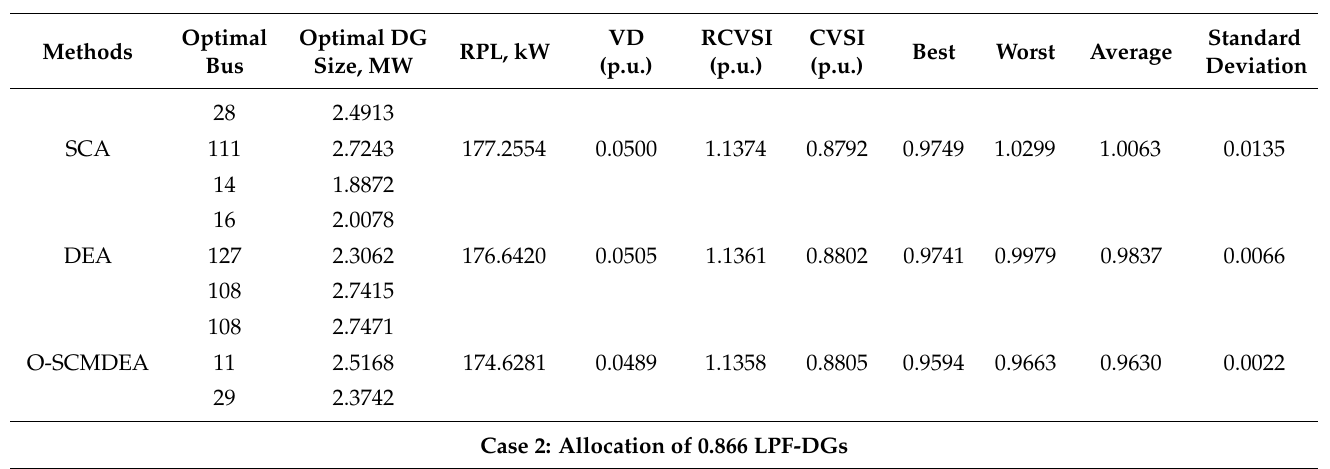
Table 15. Comparison of the results for the simultaneous optimization of the RPL, VD and RCVSI of 136 bus DN.